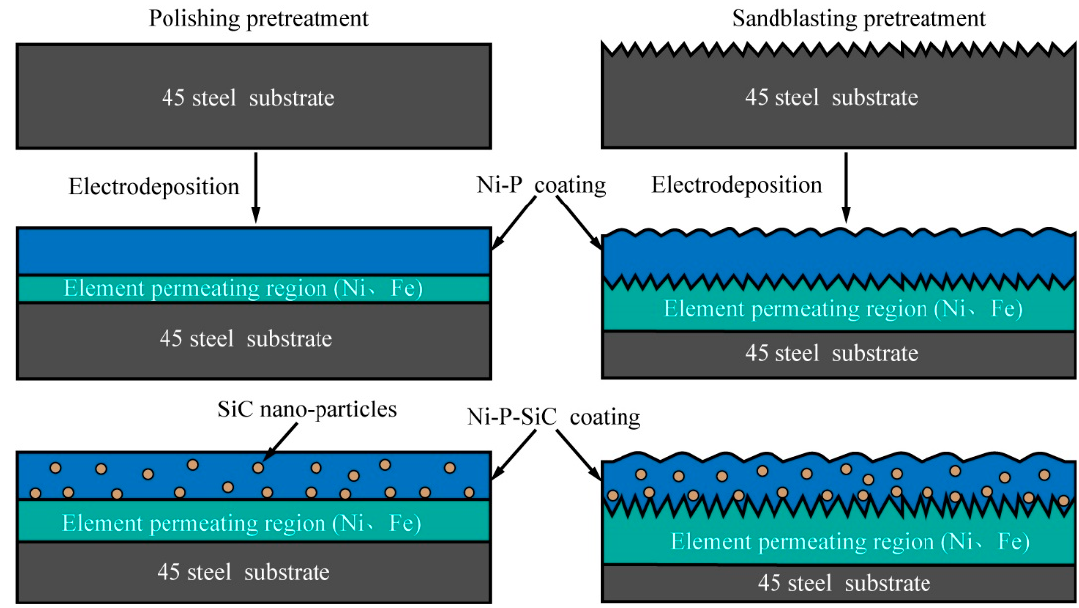
Figure 2. Experimental principle.